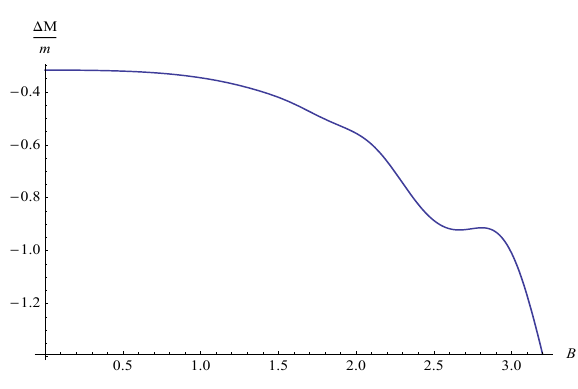
Figure 4 . Plot of (cid:1) M b =m as a function of the parameter B